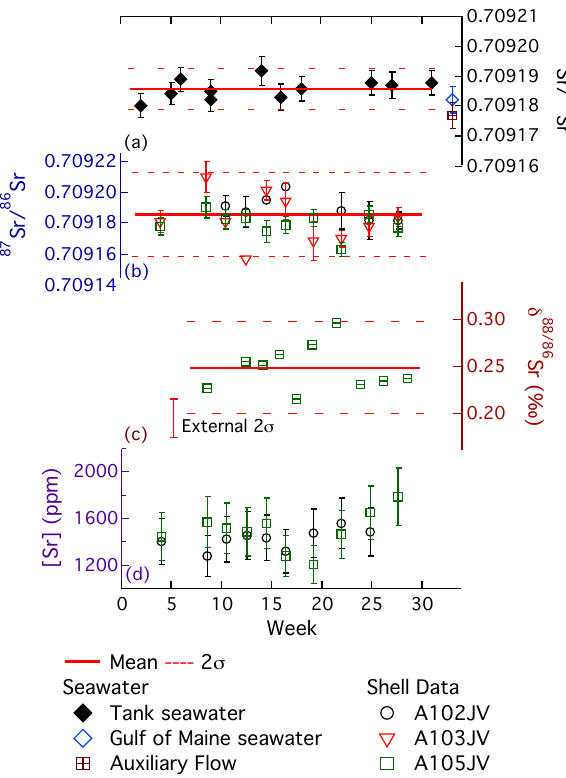
Figure 5. GoM 87 Sr/ 86 Sr data for (a) seawater samples and (b) shell samples, and the double-spike deconvolved (c) δ 88 / 86 Sr values and (d) Sr concentrations for the juvenile shell.